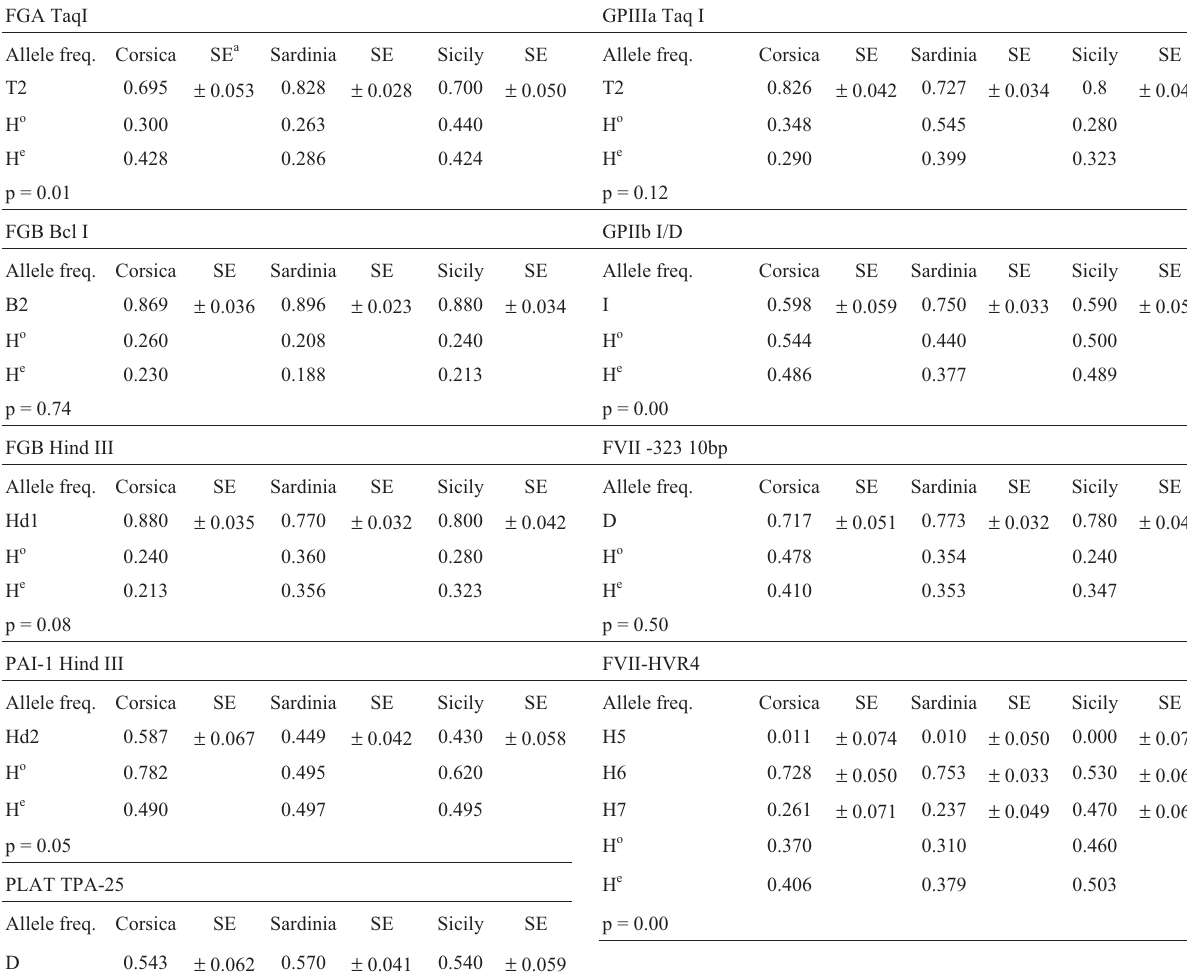
Table 3 - The allele frequencies of the haemostasis markers, heterozygosity values and p values of genic differentiation in the Corsican, Sardinian and Sicilian populations (SE = Standard Error, Ho = observed Heterozygosity and He = Heterozygosity Nei 1978, p = values of genic differentiation between populations for locus). FGA TaqI GPIIIa Taq I Allele freq. Corsica